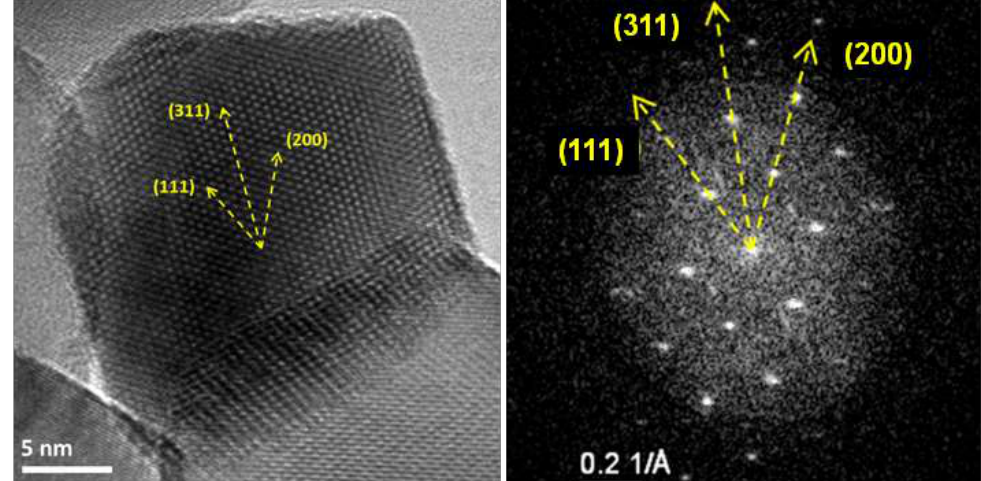
Figure 5 . HRTEM image of the Co550 catalyst with a central Co 3 O 4 single nanoparticle ( left ) and its corresponding fast Fourier transform ( right ) with both displaying the different crystal directions observed.